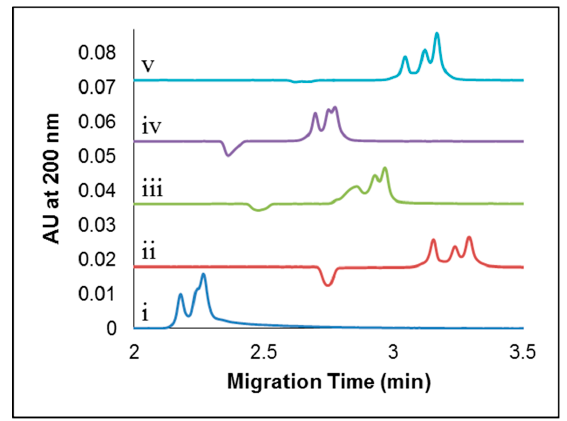
Figure 4. Separation buffer composition study for mixtures of apo- and holo-Tf (25 µM each) with CDs at pH 7.4 in different separation buffers. The separation buffers used were 10 mM phosphate ( i ), 50 mM tris-200 mM tricine ( ii ), 50 mM tris – 200 mM glycine ( iii ), 50 mm tris-500 mM glycine ( iv ), and 50 mM tris-HCl ( v ). Electropherograms are vertically offset for clarity. A volume of 1.25 nL (5.2 sec at 1.3 psi) was injected and 20 kV was applied. The separation occurred on a Beckman Coulter